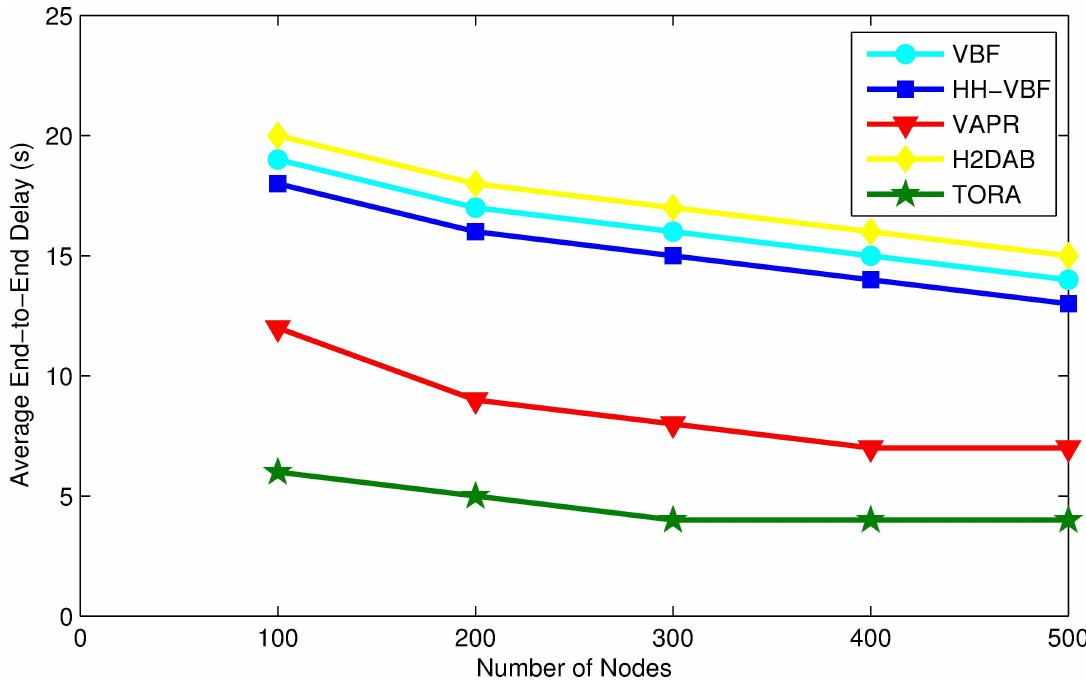
Fig 10. Average end-to-end delay vs. node